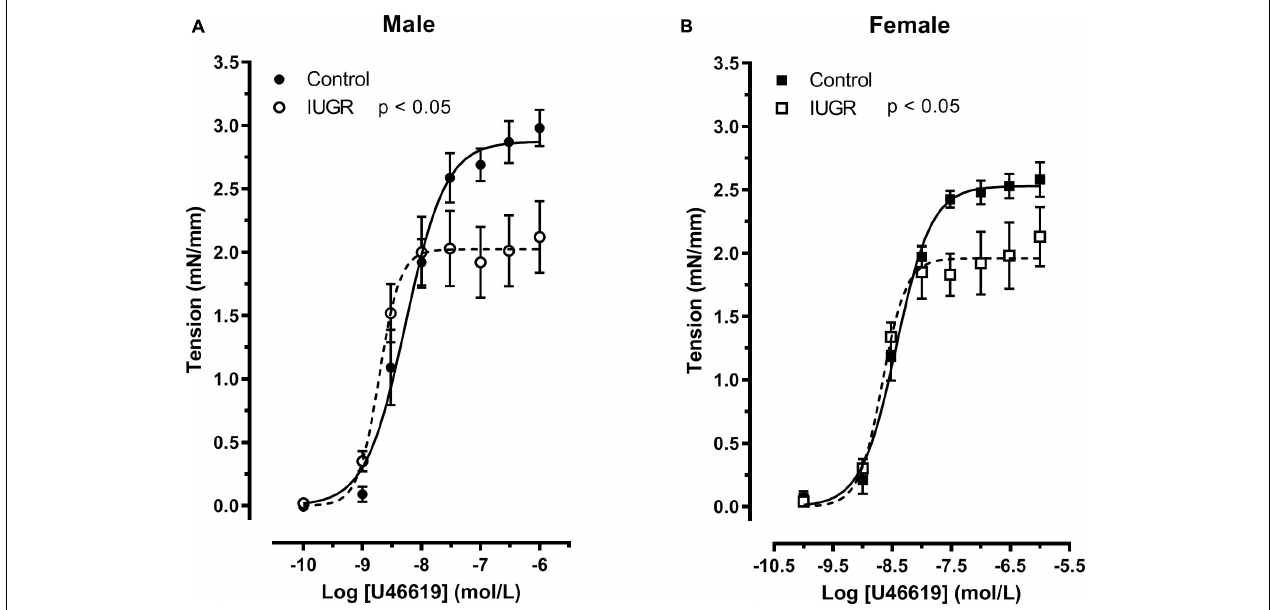
FIGURE 9 | Contractile responses to U46619 in umbilical vein of male (A) and female (B) fetuses. Each points is the mean ± SEM of animals ( n = 5) for each groups and sexes. The lines represents the best fit of all experimental